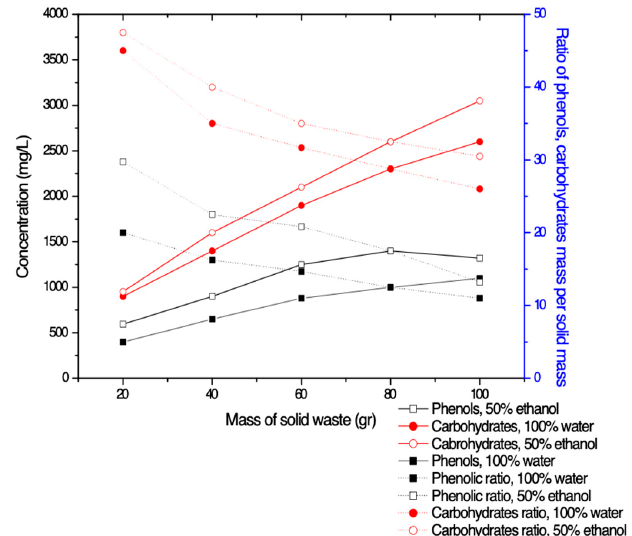
Figure 3. Concentration of TPC and carbohydrates as a function of the mass of solid waste (solid lines), and ratio of TPC and carbohydrates mass per mass of solid (dot lines).